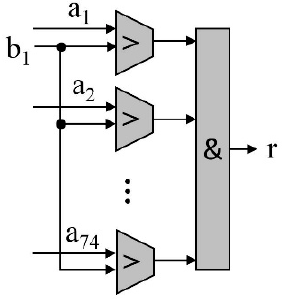
Figure 7. FPGA implementation non-maximal suppression.